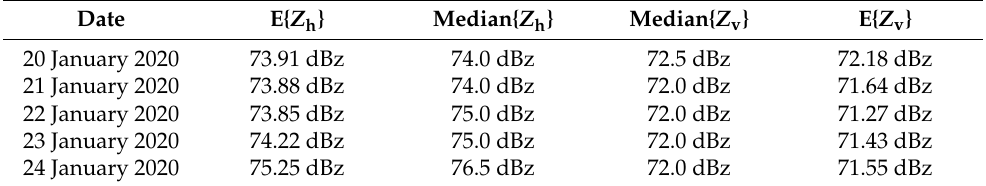
Table 7. Same as Table 5, but for January 2020, after the installation of a different calibration